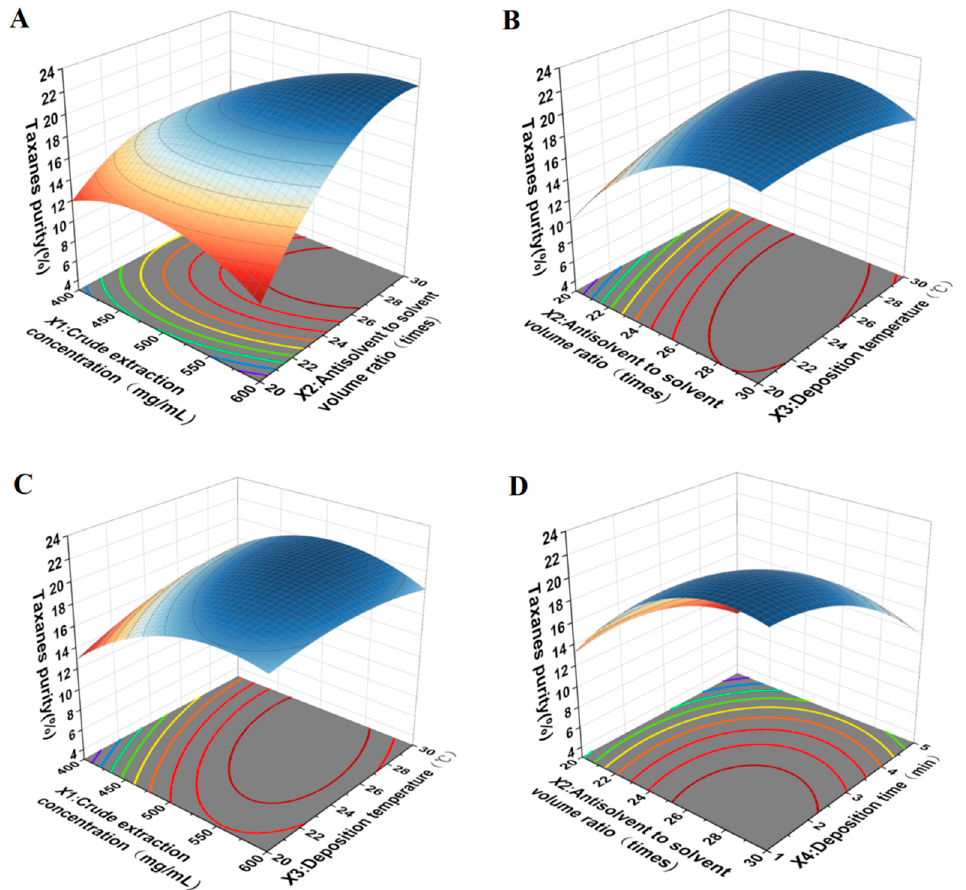
Figure 4. Interaction diagram of various factors: ( A ) crude extraction concentration and antisolvent to solvent volume ratio; ( B ) antisolvent to solvent volume ratio and deposition temperature; ( C ) crude extraction concentration and deposition temperature; and ( D ) antisolvent to solvent volume ratio and deposition time.